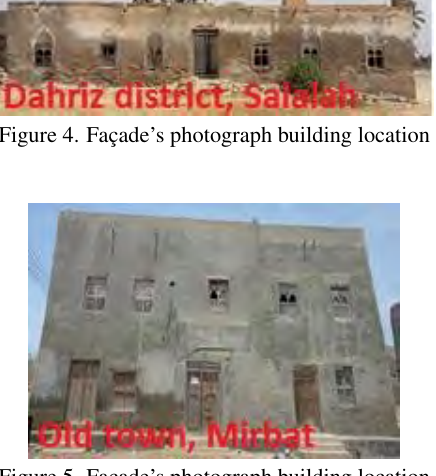
Figure 5. Fac¸ade’s photograph building location